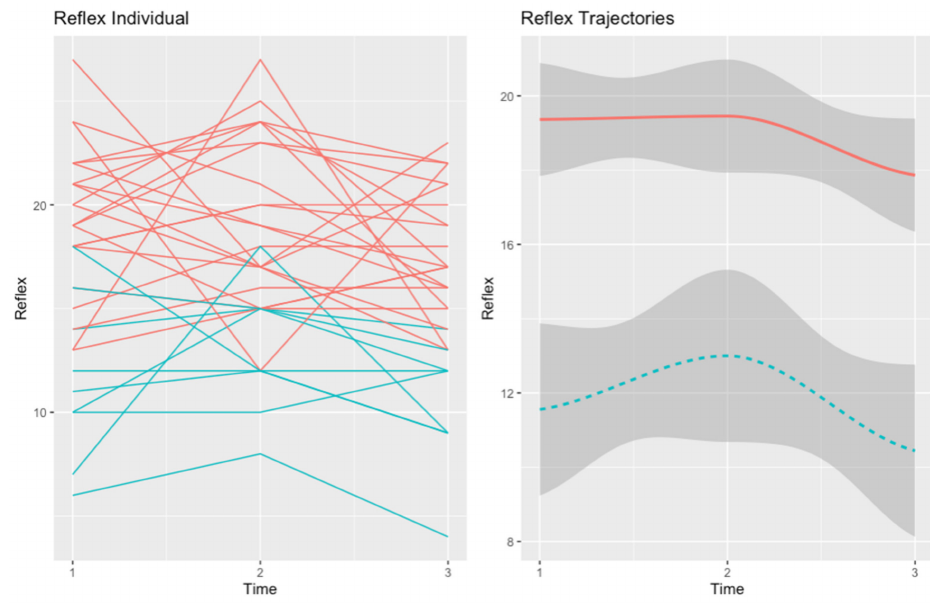
Figure 1. Trajectories of self-reflectivity in the MCT group. The red trajectory depicts the “High SR” trajectory (n = 20). The second trajectory (in blue), refers to “Improving SR” (n =